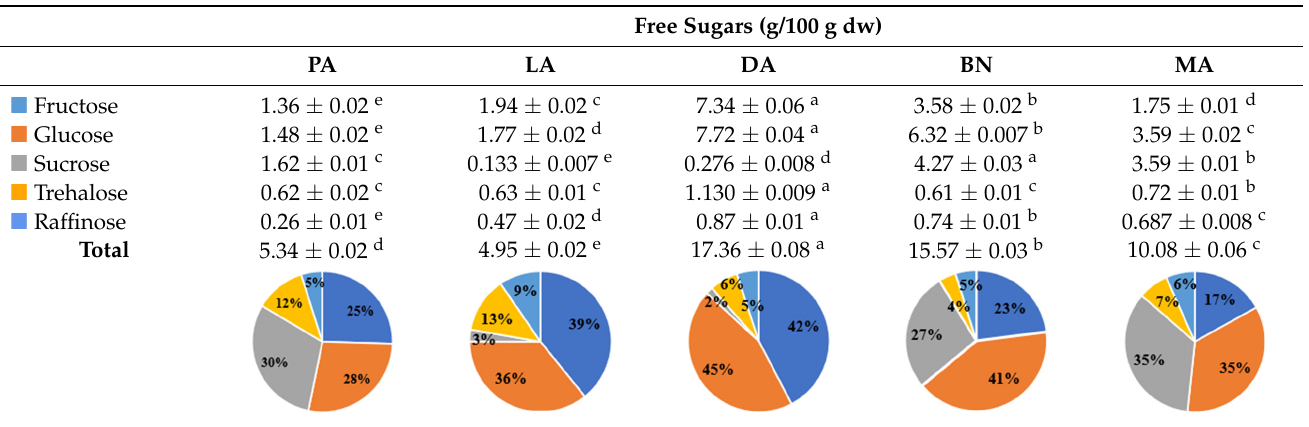
Table 3. HPLC-IR characterization of free sugar content in fig leaves.